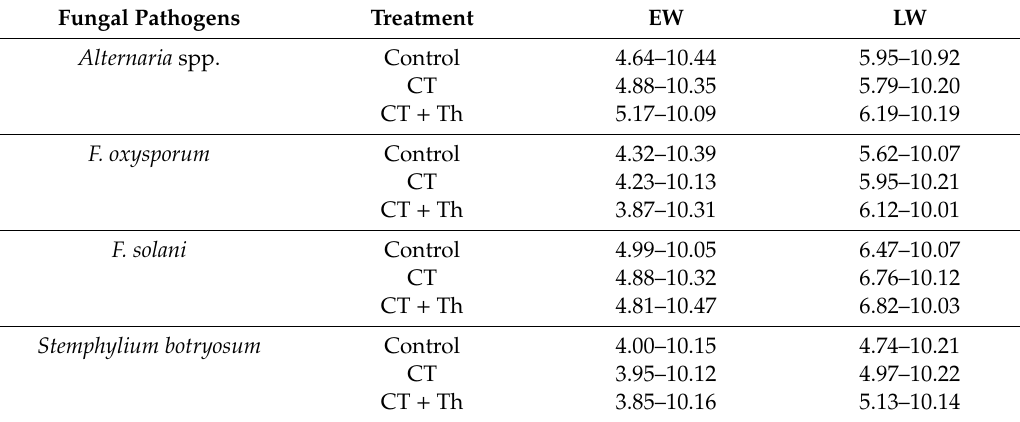
Table 5. Influence of different compost tea (CT) treatments on abundance (log copies gen g − 1 soil) of fungal pathogen in soil after harvesting in both experiments. Values are the mean + SD; n = 3). Control: sprayed distilled water (12 m 3 per ha); CT: sprayed compost tea (12 m 3 per ha); CT + Th: